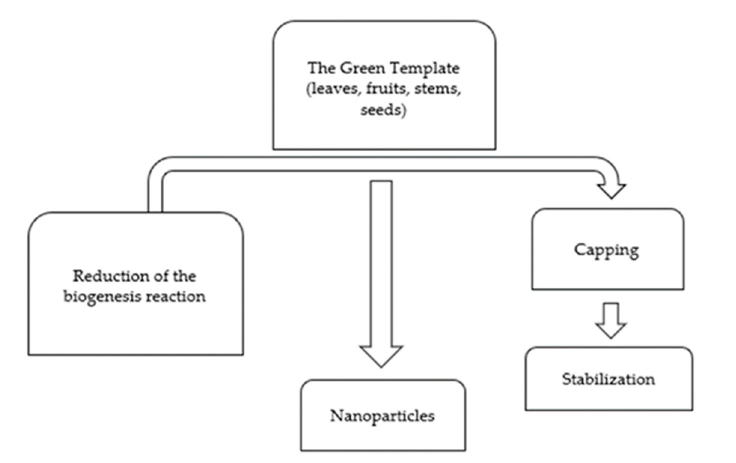
Figure 3. The basic process of the green synthesis of nanoparticles, adopted from [20].